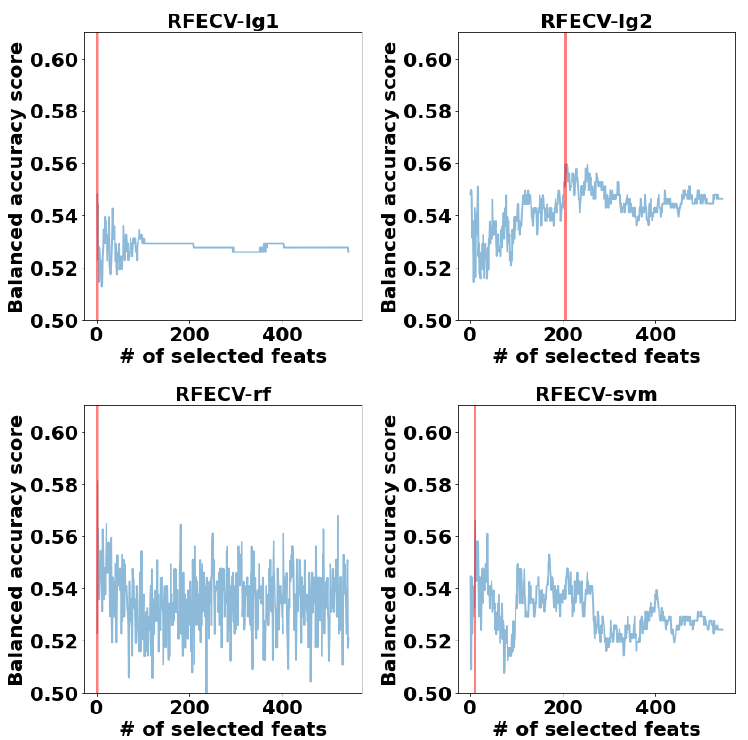
Figure 7. The number of selected features vs. the balanced accuracy score when applying RFECV with different classifiers. The red vertical line labels the number of features corresponding to the maximum balanced accuracy